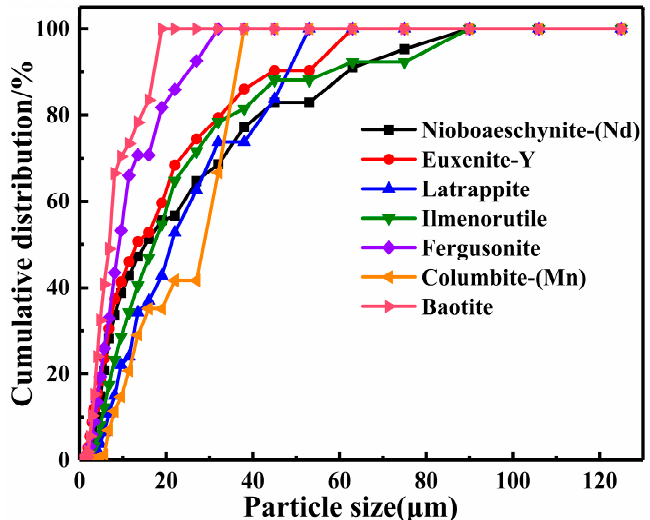
Figure 6. Cumulative particle size distributions of niobium-bearing minerals. Table 5. Particle size distributions of niobium-bearing minerals (%).